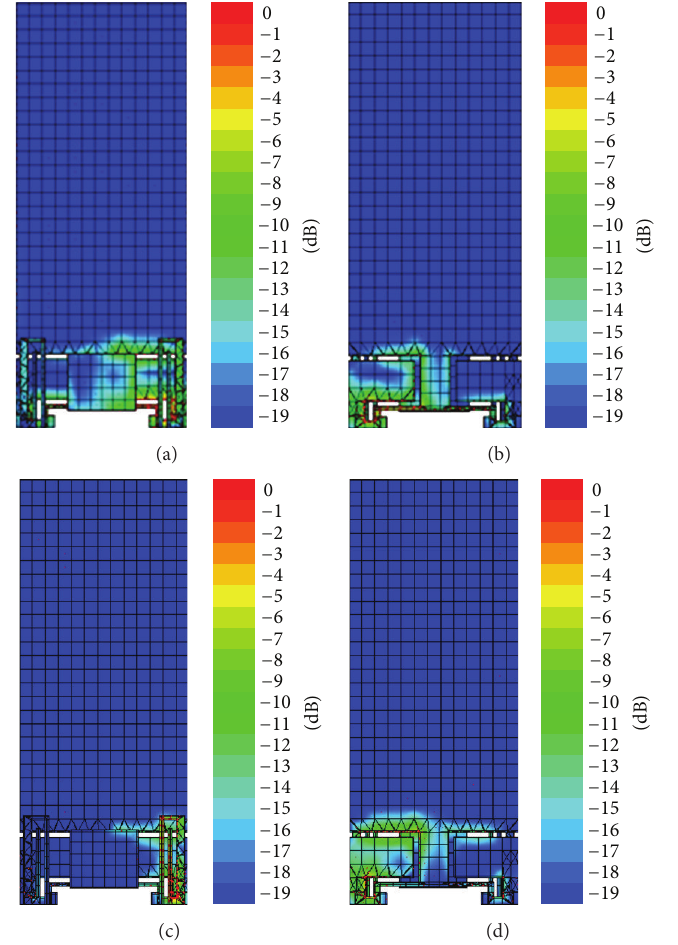
Figure 9: (a) Front view of surface current distributions at 780 MHz when Port 1 is excited. (b) Back view of surface current distributions at 780 MHz when Port 1 is excited. (c) Front view of surface current distributions at 2.350 GHz when Port 1 is excited. (d) Back view of surface current distributions at 2.350 GHz when Port 1 is